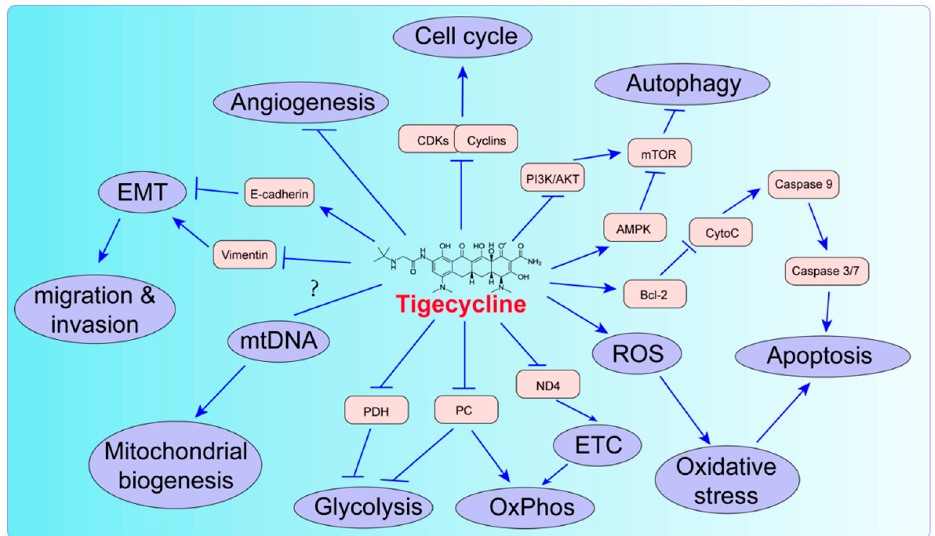
Figure 1. The biological effects of tigecycline in cancer cells. Tigecycline treatment induces decrease in OxPhos, dysfunction of mitochondria, inhibition of EMT and migration/invasion, suppression of angiogenesis, arrest of cell cycle, increase of ROS and oxidative stress/damages, promotion of intrinsic apoptois and activation of autophagy. CytoC, cytochrome C; EMT, epithelial–mesenchymal transition; ETC, electron transfer chain; mtDNA, mitochondrial DNA; ND4, NADH dehydrogenase subunit 4; OxPhos, oxidative phosphorylation; PC, pyruvate carboxylase; PDH, pyruvate dehydrogenase; ROS, reactive oxygen species.